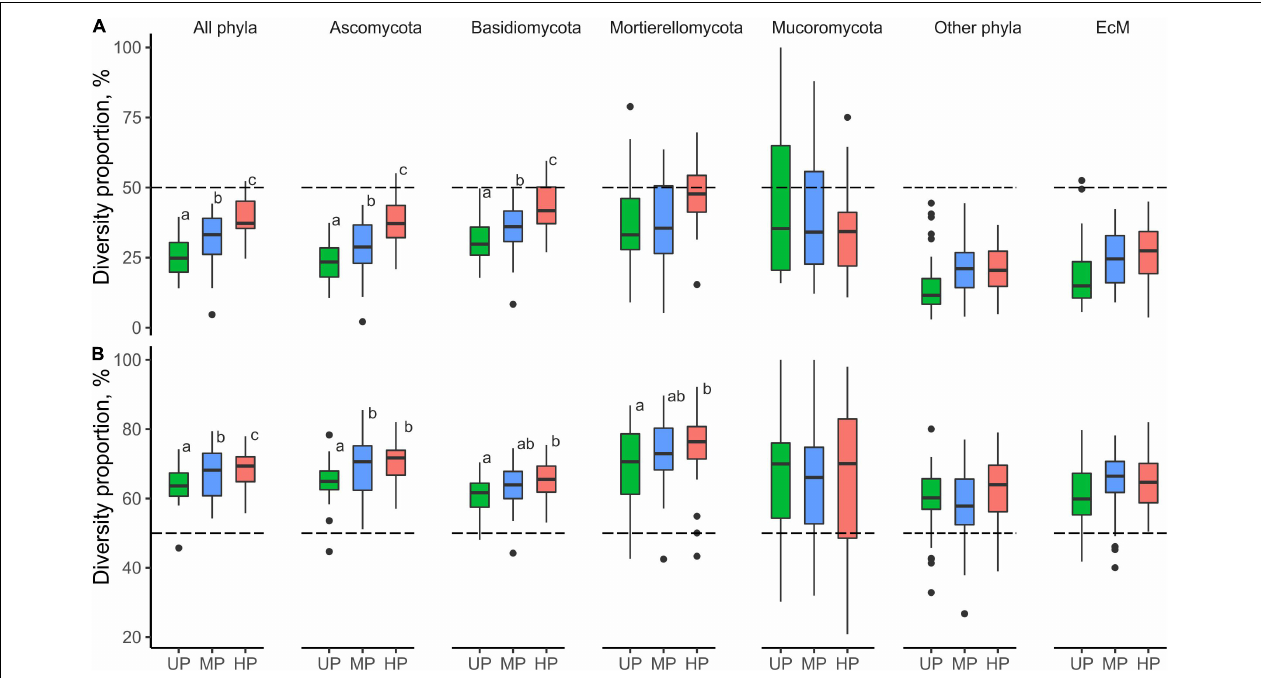
FIGURE 5 | The ratio of OTU numbers revealed in (A) wood and (B) CWD-influenced litter samples to CWD-uninfluenced litter samples in the areas with different levels of pollution. Different letters indicate statistically significant differences of mean values between areas, revealed with Tukey’s test ( p < 0.05, n = 29; Supplementary Table 6 ). A few outliers in Mucoromycota are not shown due to clipping of the y -axis at the top for readability (however, the analysis was performed on the full dataset). OTU, operational taxonomic unit; CWD, coarse woody